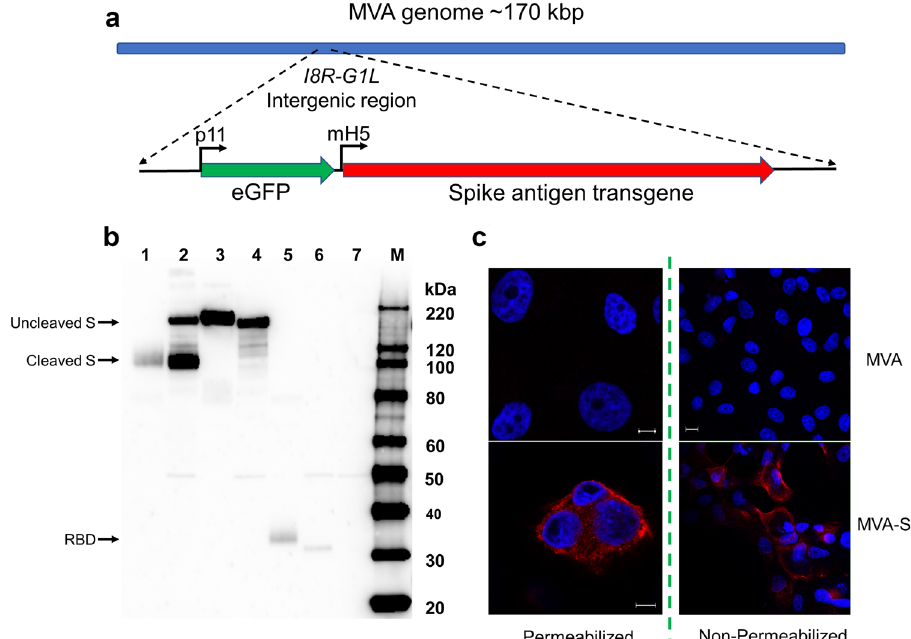
Fig. 1 Construction and characterization of recombinant MVA SARS-CoV-2 antigens. a Schematic diagram of the MVA vector design. b Western blot analysis. Con fl uent monolayers of Vero cells in a 6-well plate were infected with MVA-S, MVA-ssM, MVA-RBD, or MVA. The supernatants and the infected cells were collected after 6 h and processed for Western blot with a rabbit anti-SARS-CoV-2 spike protein polyclonal antibody. Images were captured using an LAS3000 imaging system (Fuji fi lm). Lane 1: MVA-S supernatant, lane 2: MVA-S cell lysate, lane 3: MVA-ssM supernatant, lane 4: MVA-ssM cell lysate, lane 5: MVA-RBD supernatant, lane 6: MVA-RBD cell lysate, lane 7: MVA cell lysate, lane M: MagicMark protein molecular weight markers. The blot was derived from a single experiment that was repeated one time. The uncropped blot is shown in Supplementary Fig. 1. c Confocal microscopy. MVA- or MVA-S-infected Vero E6 cells were fi xed in 4% paraformaldehyde. Cells were either permeabilized in 0.2% Triton X-100 or left untreated (non-permeabilized) and subsequently stained with a polyclonal anti-SARS-CoV-2 spike antibody (GTX135356) (red). Nuclei were counterstained with DAPI (blue). Scale bars represent 5 µm (left) and 10 µm